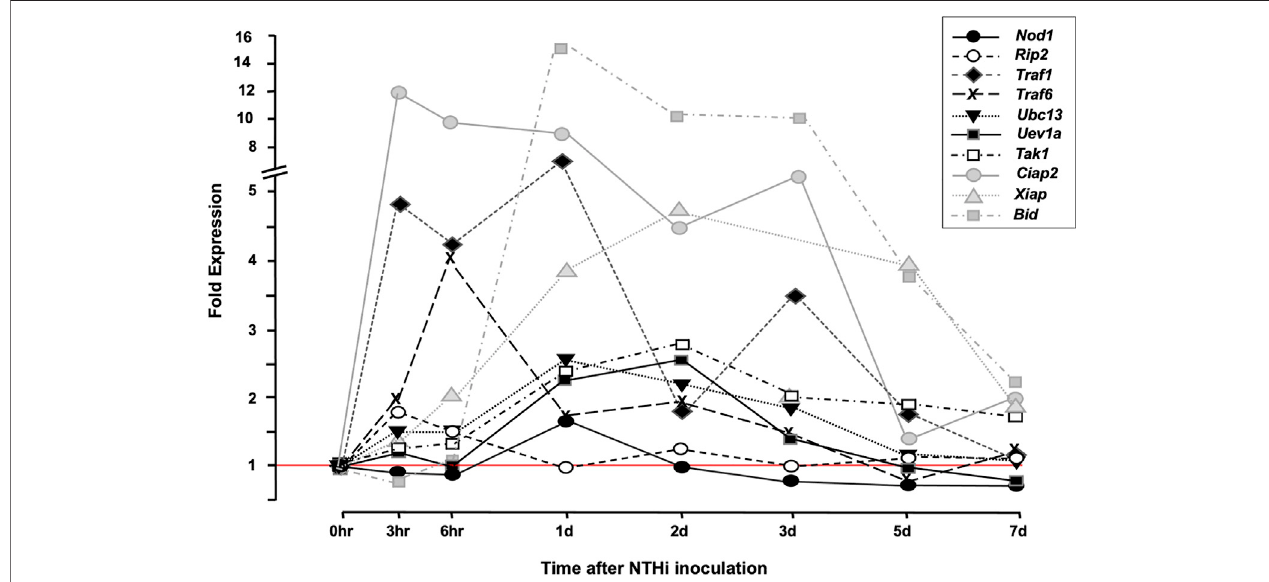
FIGURE2| cDNAArraydata.ArraydatafrombulkMERNAprovide anoverviewofgeneexpression intheMEduring OM.The fi gure presents acomparison ofME geneexpressionduringacompleteepisodeofacuteMEinfectionduetoNTHiinoculation,withthatobservedpriortoinfection.ManyRIP-relatedgenesareup-regulated within hours of ME infection [The data for Nod1 , Ripk2 , Ubc13 , and Traf6 were published in a prior study (Lee et al., 2019), and are presented here for comparison with other RIP2-related